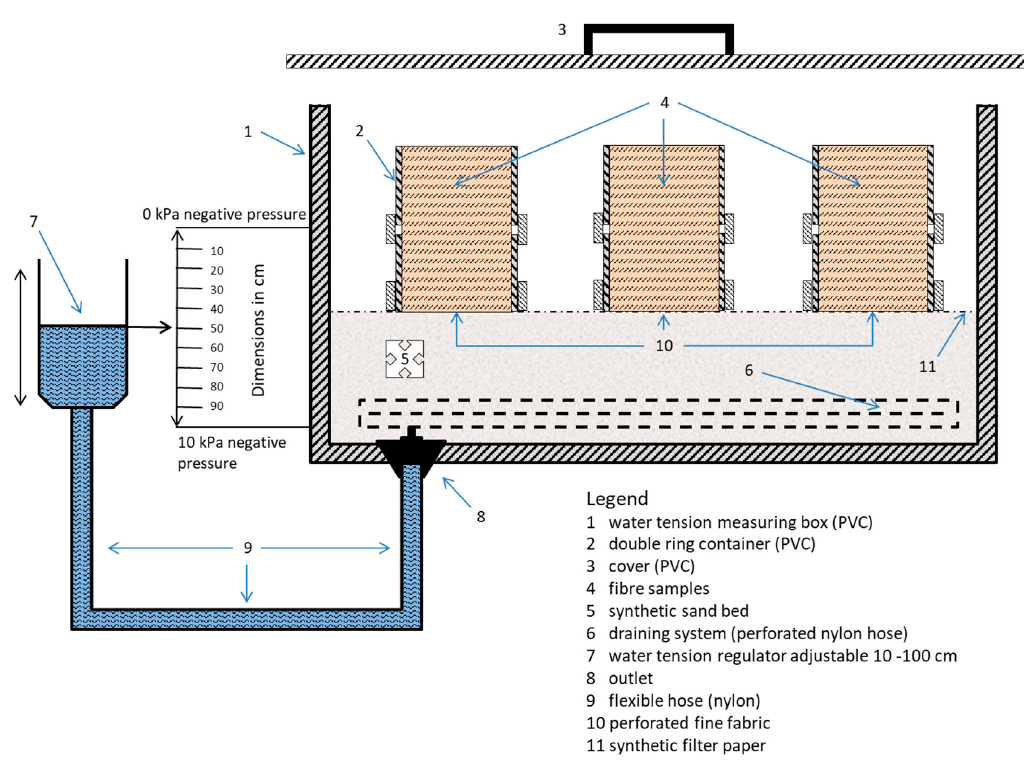
Figure 2. Experimental design of the twin-screw extruder.